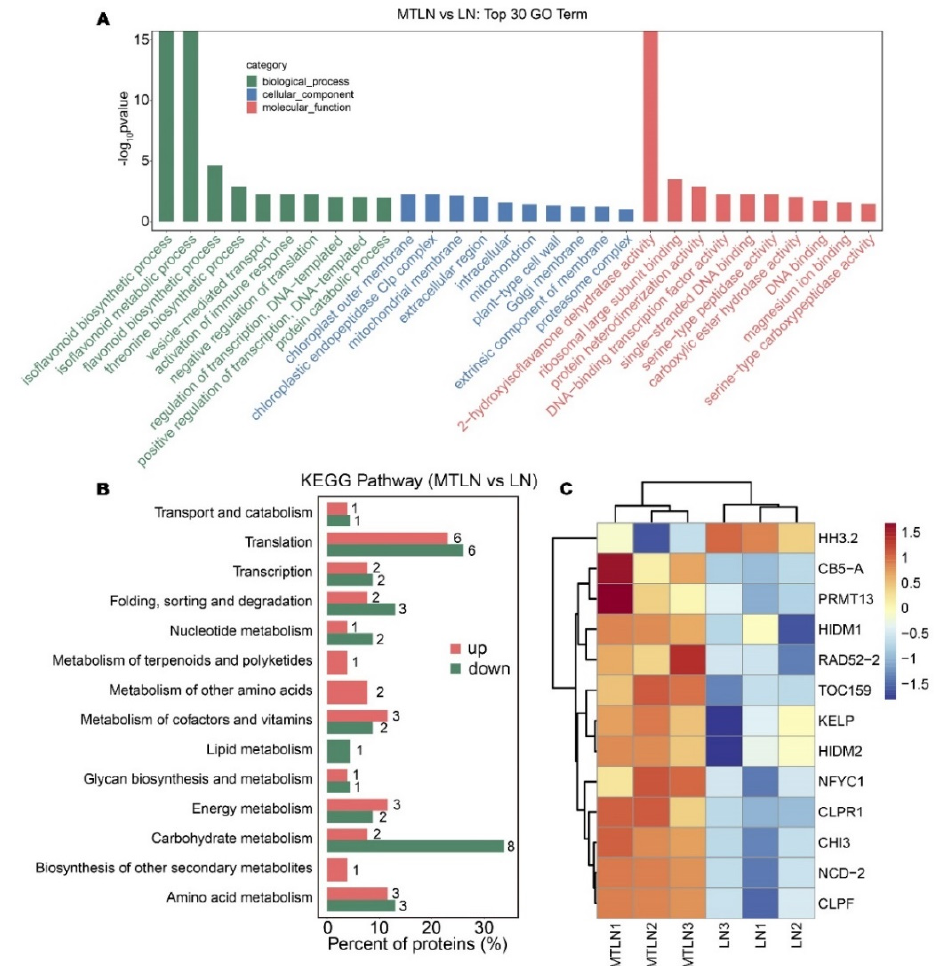
Figure 8. Go and KEGG enrichment analysis of melatonin in the regulation of DEPs in tomato leaves at low night temperatures. Analysis of enriched GO terms ( A ), KEGG metabolic pathways ( B ), and selected DEPs between LN and MTLN plants ( C ).